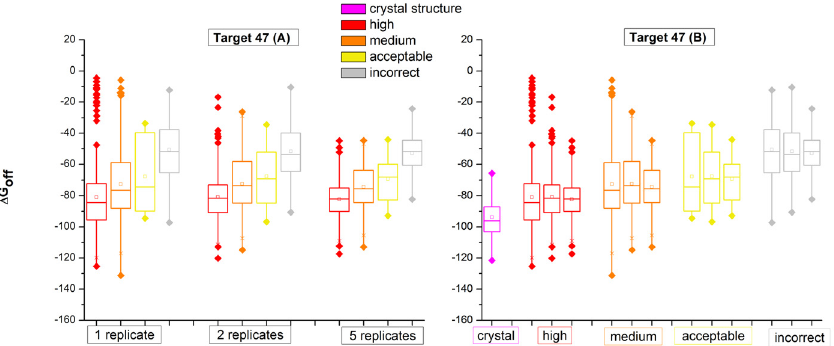
Fig 2. Distribution of 4 G off for structures in different quality categories (Target 47). (A) 4 G off